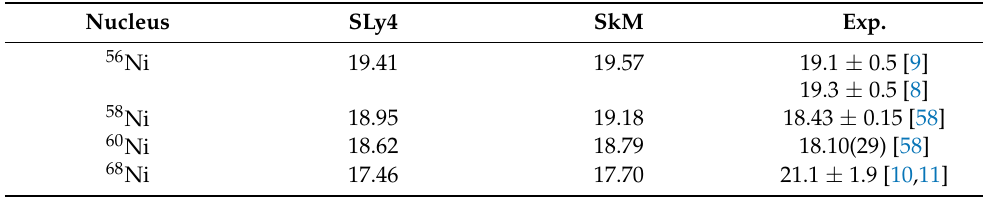
Table 1. The values of the centroid energies E ISGMR (in MeV) of Ni isotopes obtained from HF+CDFM calculations in this work using SLy4 and SkM Skyrme forces compared with the experimental data found in the